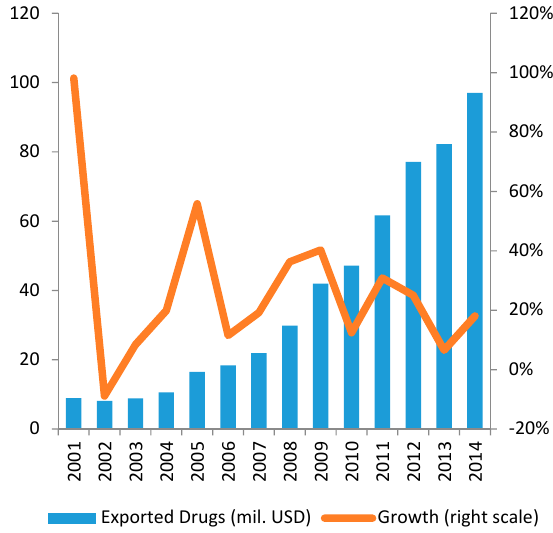
Figure 6. Exports Volume of Drugs in 2001–2014.